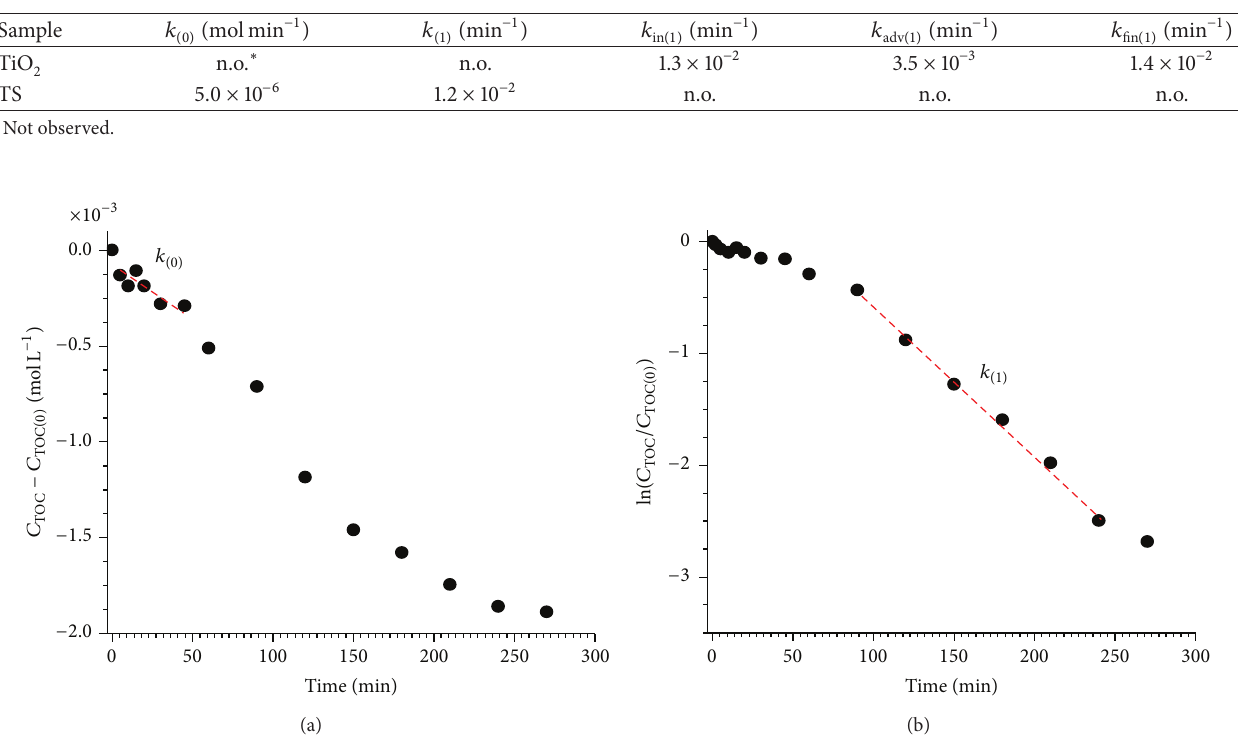
nanocrystals and TS composite for the photomineralization of DCF. 2